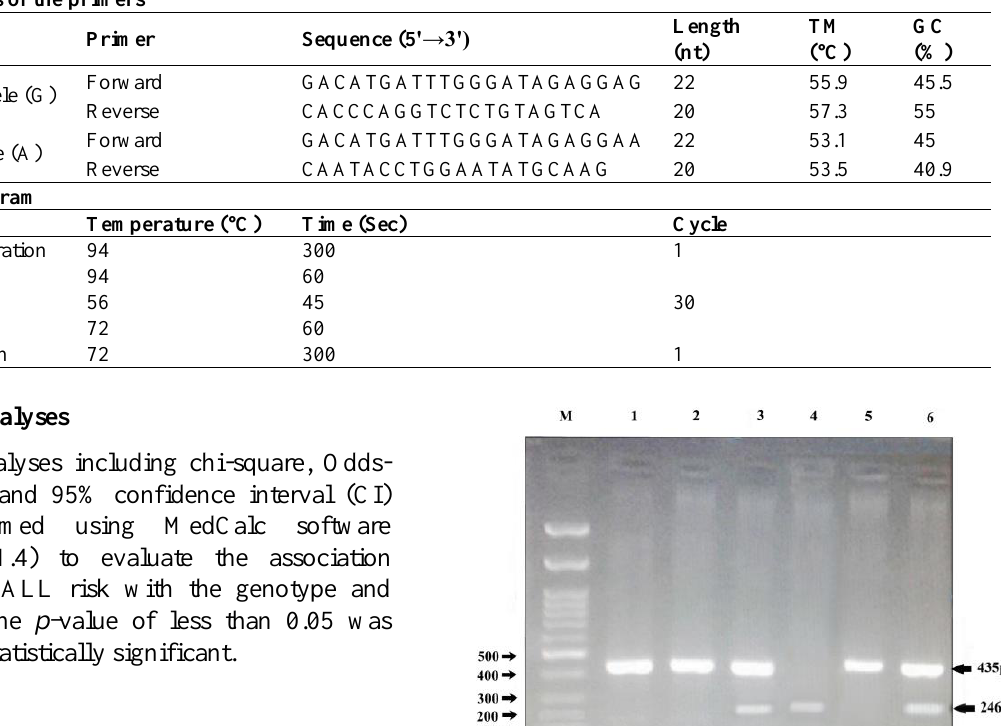
Table 1. Sequences of the primers and PCR program. A) Sequences of the primers